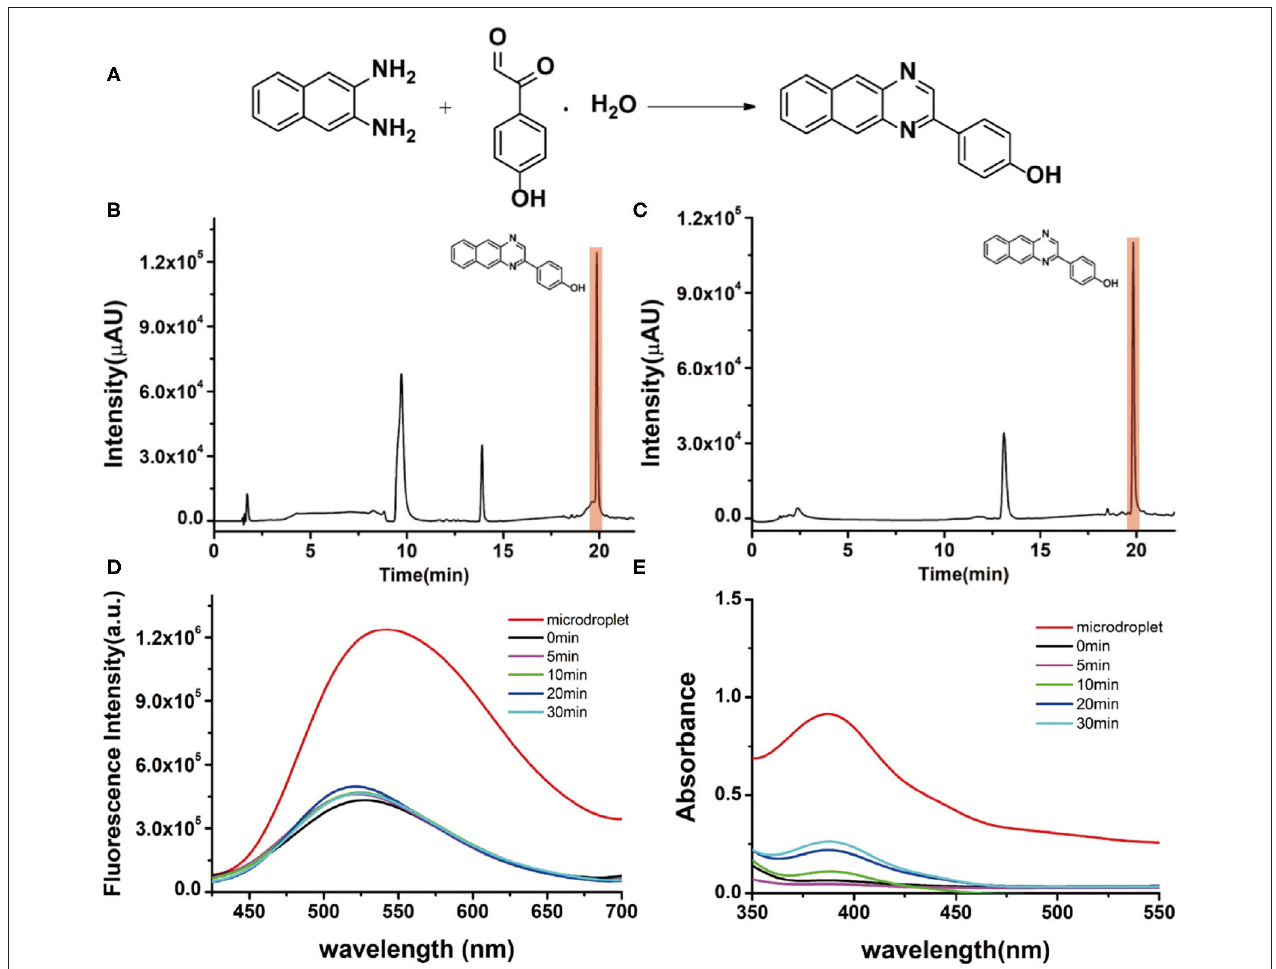
FIGURE 5 | (A) The synthesis of the fluorescent viscosity probe. Chromatographic results of LC-MS for the products (B) in bulk-phase stirring for 10min and (C) in the microdroplet. (D) Fluorescence emission spectra of the products of the microdroplet reaction and bulk reaction at different reaction times (0, 5, 10, 20, 30min). (E) UV/visible spectra of microdroplet reactions and bulk reaction at different reaction times (0, 5, 10, 20, 30 min).